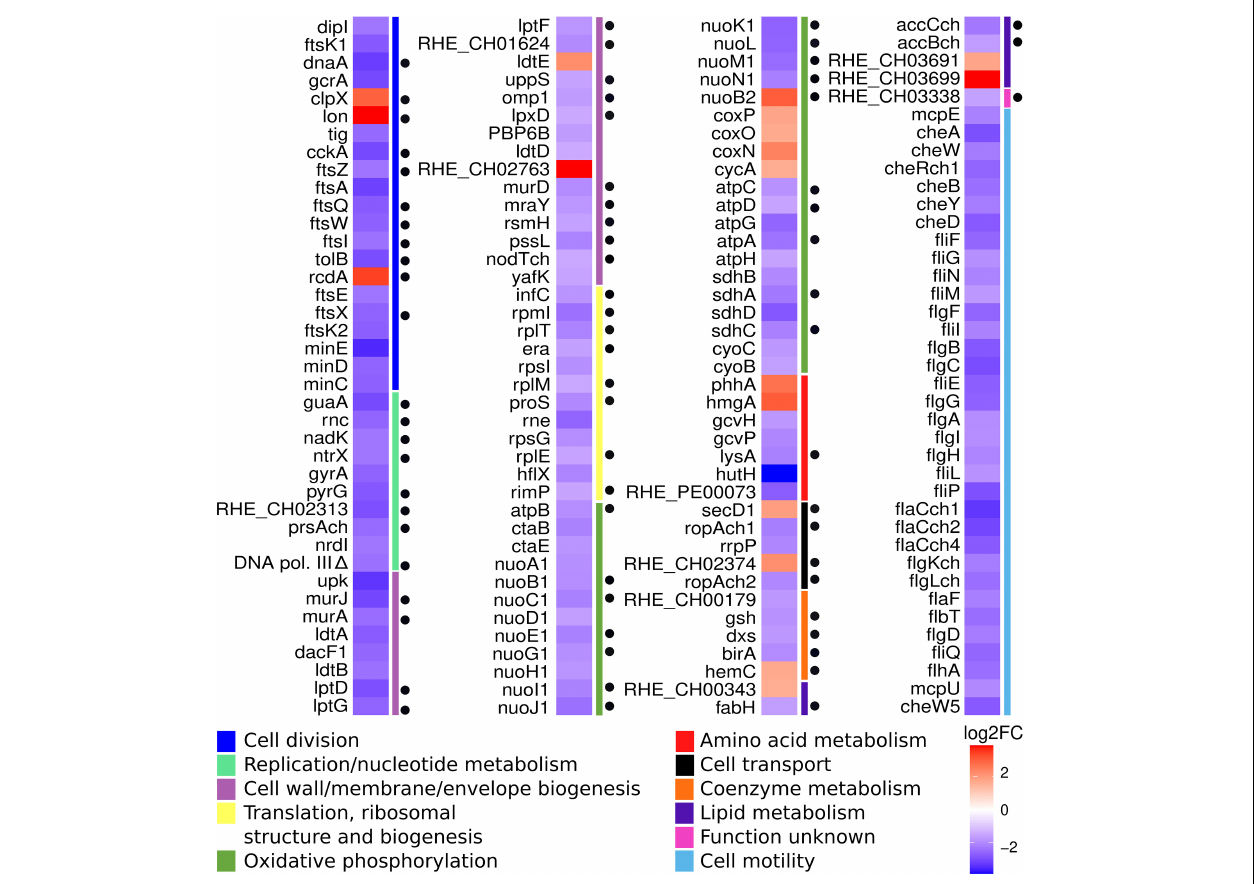
FIGURE 5 | DEGs detected under RdsA depletion correspond to possible essential genes. Heatmap showing significant DEGs in the cKD24 mutant, grouped according to their function (colored bars at the right of the map), based on the COG database (see legend at the bottom). Red, upregulated DEGs; blue, downregulated DEGs (cutoff threshold of log2FC ≥ 1.5 and P-adj/FDR ≤ 0.02). Black circles located on the right side of the heatmap mark orthologs to essential genes of A. tumefaciens